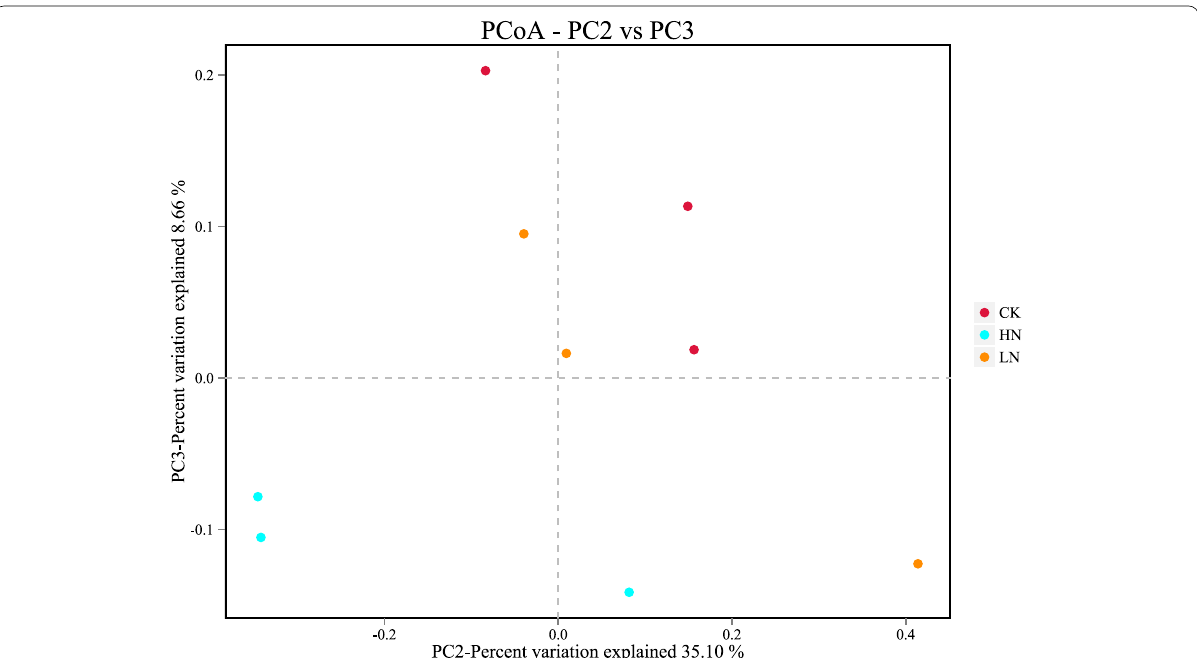
Note: Significant differences ( P < 0.05) are indicated by the different letters in each column